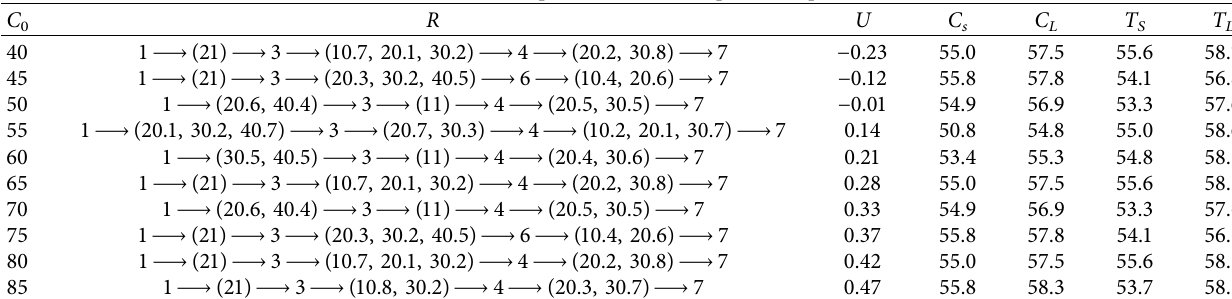
Table 6: The impact of C 0 on transportation plans.